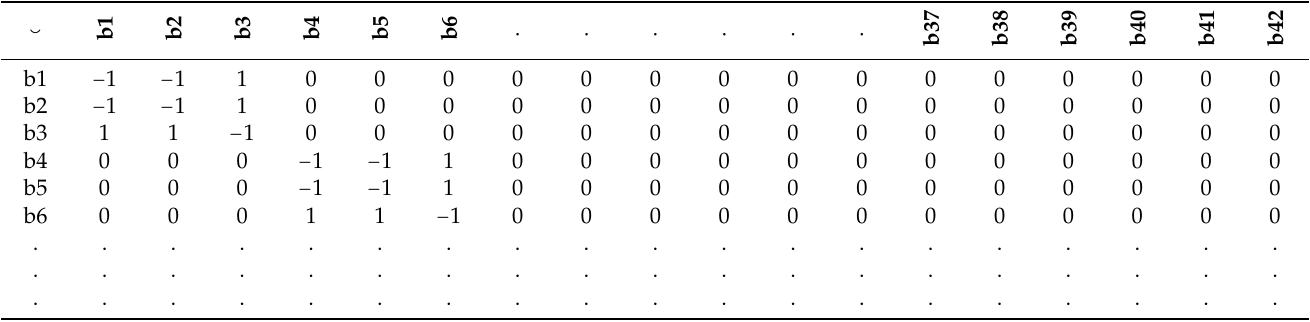
Table A6. Cup product of the cocycles deduced from the homeomorphic representation of Figure 21